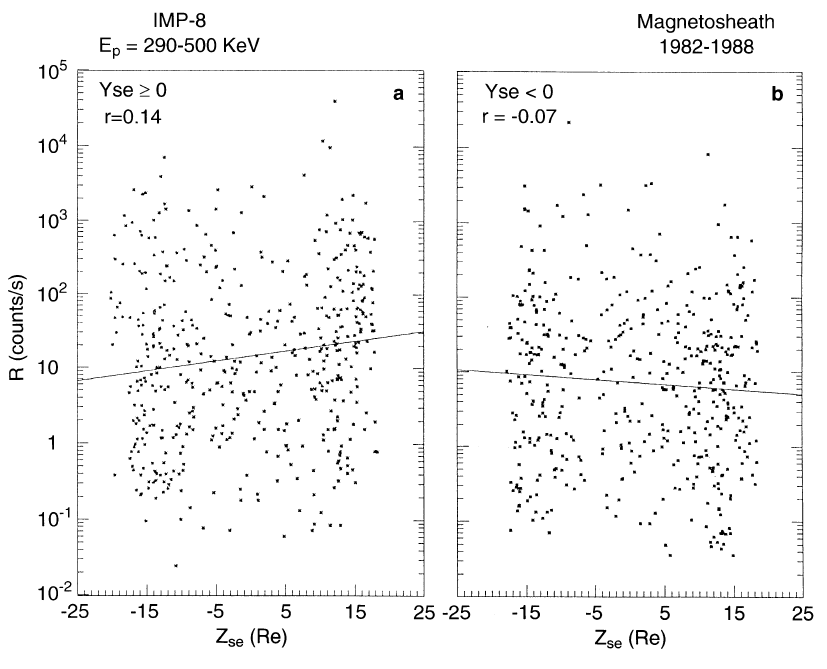
Fig. 6a,b. The distribution of the counting rate of 290–500 keV as a function of the latitudes in the a dusk and b dawn